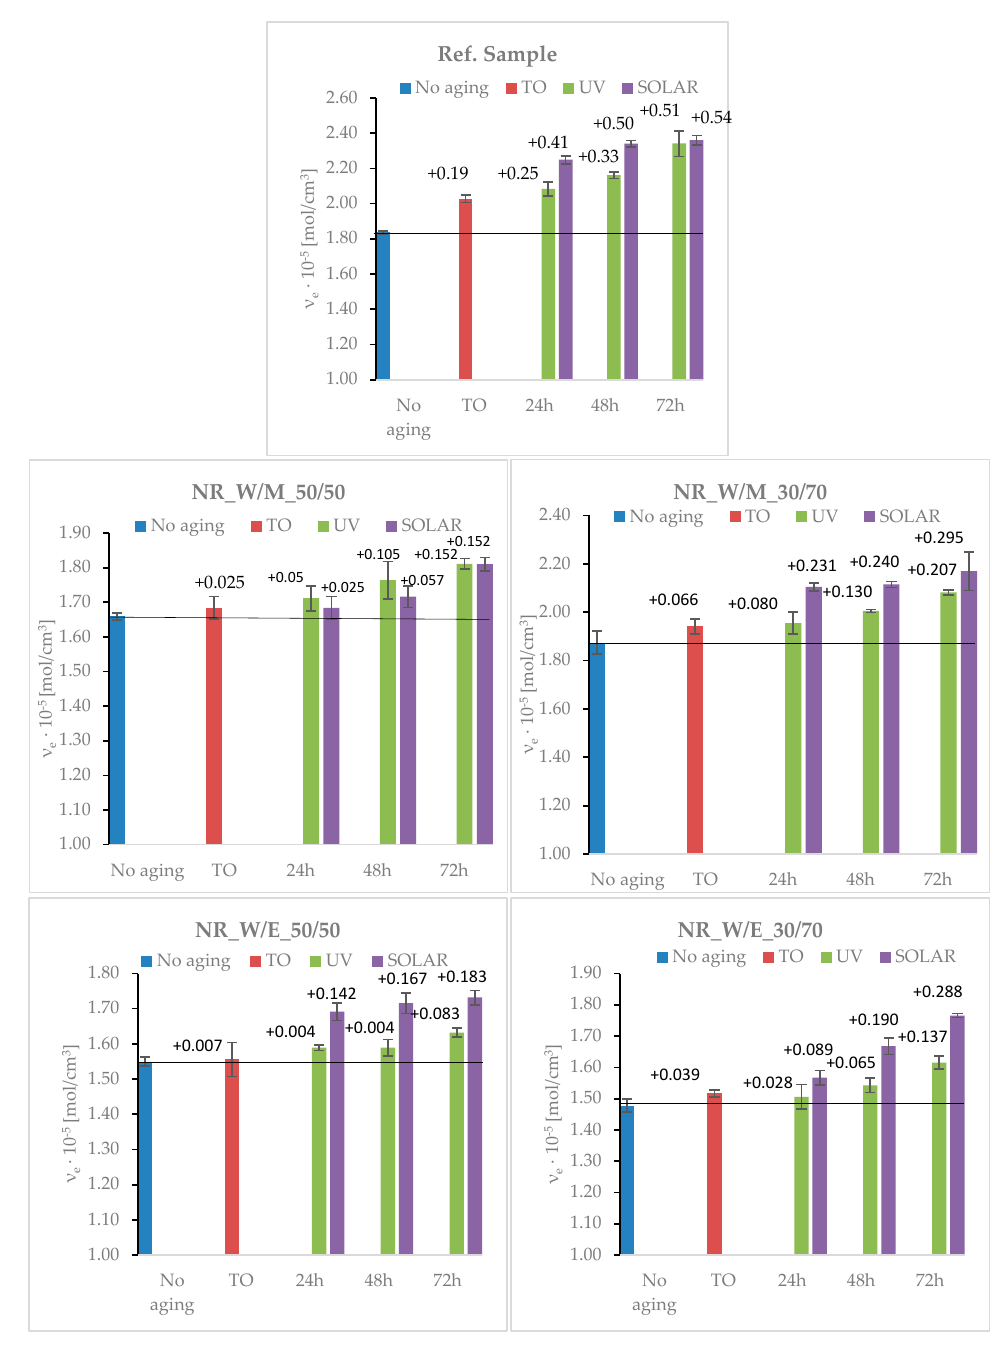
Figure 4. The cross-linking densities of vulcanizates before and after simulated aging processes: thermo-oxidative (TO), UV and